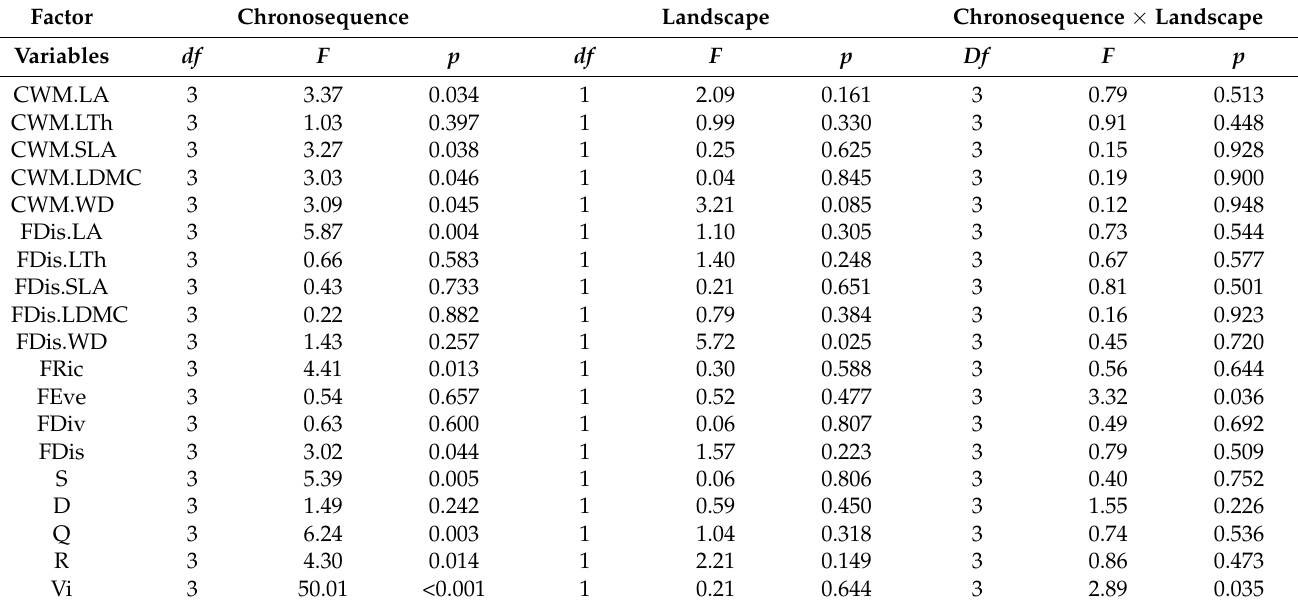
Table 1. Effects of chronosequence and landscape on different plant functional attributes along succession in the Colombian Andean–Amazonian